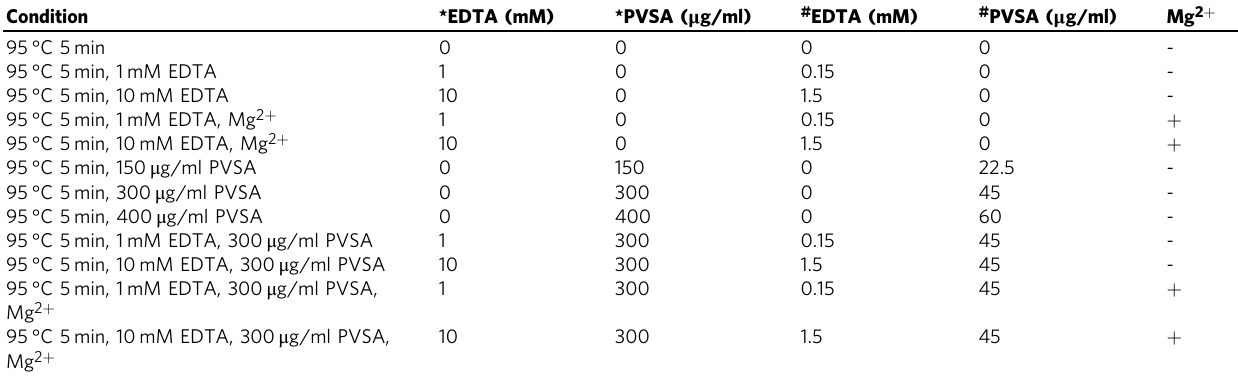
Table 2 Heat-inactivation conditions tested for SARS-CoV-2 hid-RT-PCR optimisation. Condition